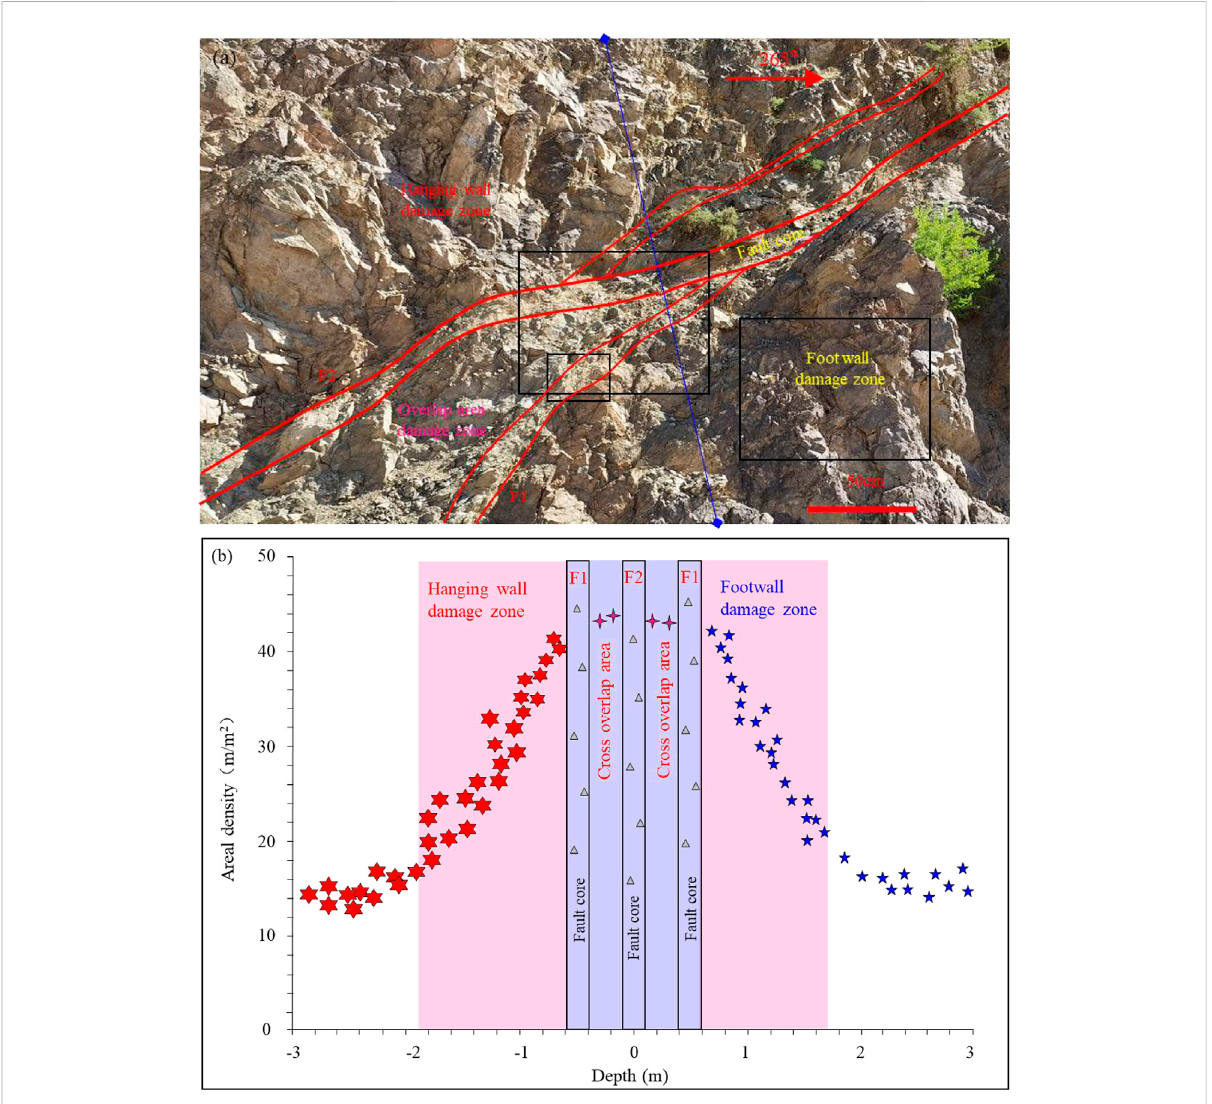
FIGURE 8 Fault structure and distribution of associated fractures at Huoqing Road. (A) The overall characteristics of Huoqing Road fault; (B) internal structure of fault zone and distribution of associated